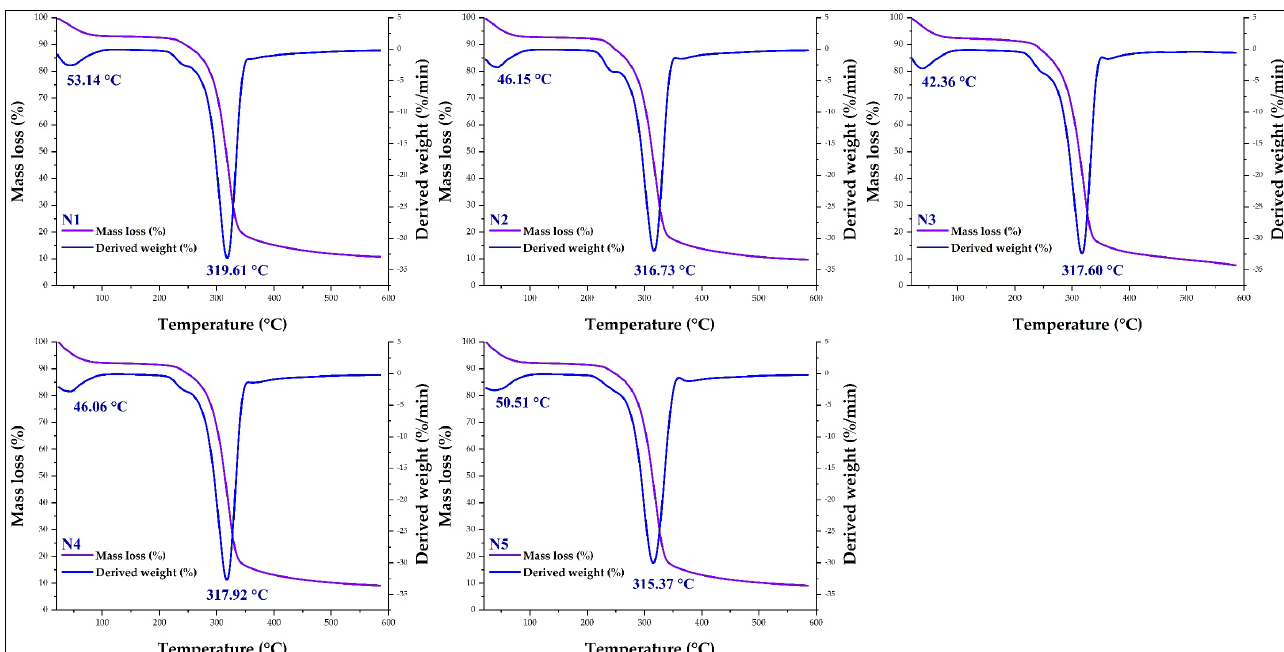
Figure 7. TGA and DTA curves of the nanoencapsulates (N1, N2, N3, N4, and N5).